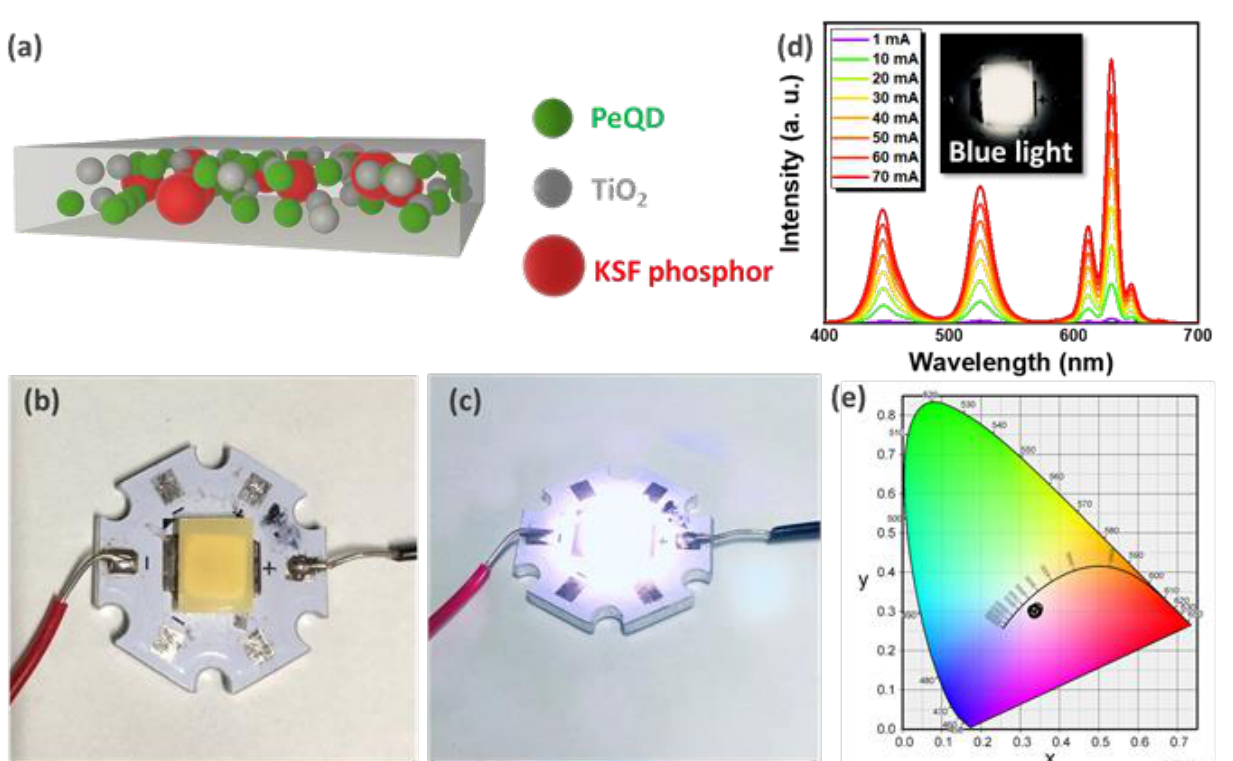
Figure 3. Optical properties of white PeQD composite film. ( a ) Schematic image of film formation. ( b , c ) Optical image of white-light LED (20 mA) with and without illumination. Current variation test ( d ) emission spectrogram and ( e ) CIE color coordinates.